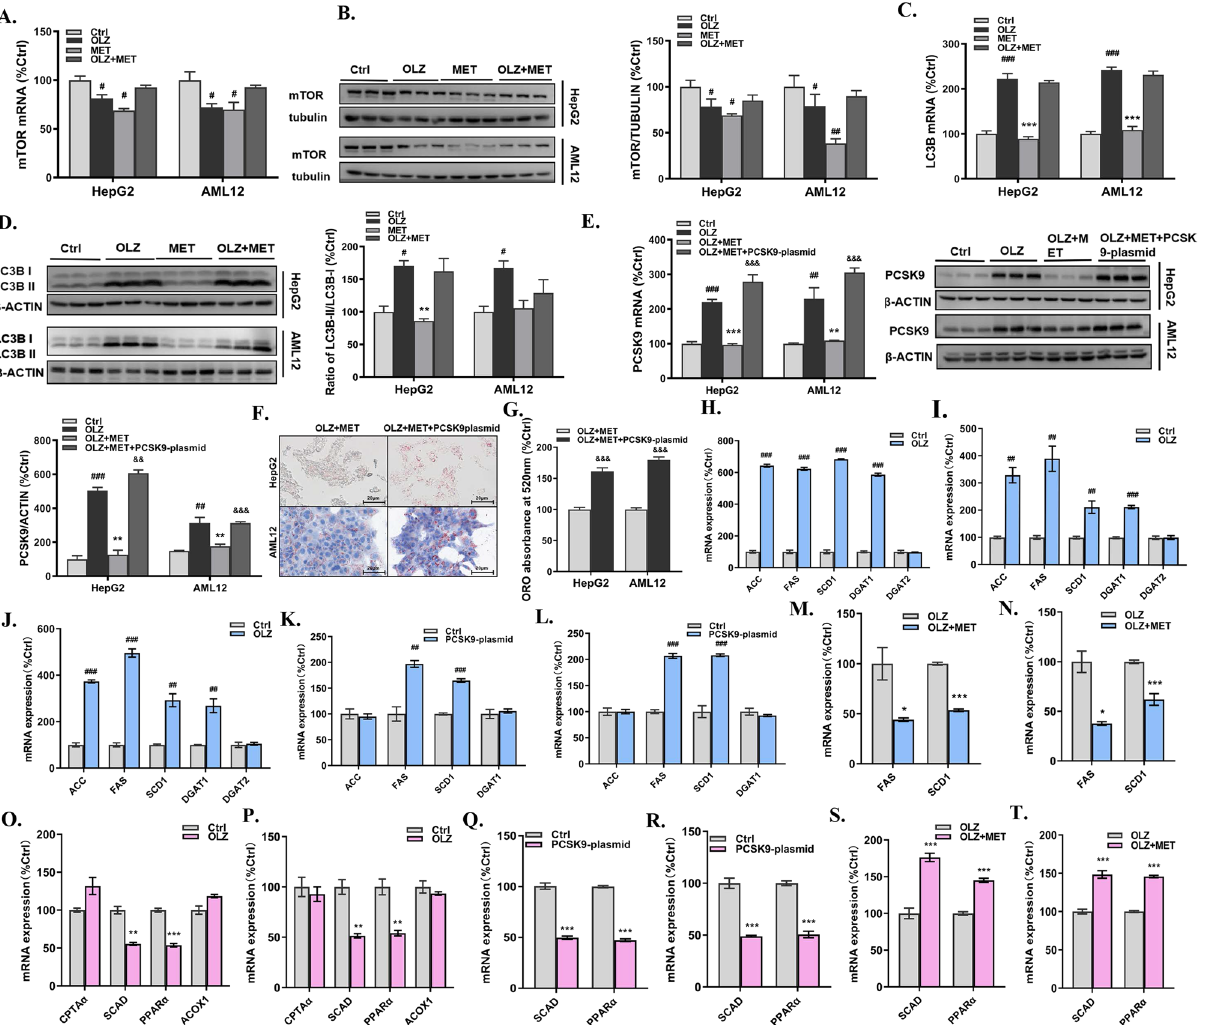
Figure 3. Metformin alleviates olanzapine-induced hepatic lipid accumulation by inhibiting PCSK9 and lipid synthesis-related gene expression in vivo and in vitro. mTOR ( A ) mRNA and ( B ) protein levels in HepG2 cells and AML12 cells. ( C ) LC3B mRNA levels in HepG2 cells and AML12 cells. ( D ) Ratio of LC3B II/LC3B I in HepG2 cells and AML12 cells. ( E ) PCSK9 mRNA and protein levels in HepG2 cells and AML12 cells treated with the PCSK9 plasmid. ( F, G ) ORO staining of HepG2 cells and AML12 cells treated with the PCSK9 plasmid. ACC, FAS, SCD1, DGAT1, and DGAT2 mRNA levels in ( H ) mouse liver tissues, ( I ) HepG2 cells and ( J ) AML12 cells. ACC, FAS, SCD1and DGAT1 mRNA levels in ( K ) HepG2 cells and ( L ) AML12 cells treated with the PCSK9 plasmid. FAS and SCD1mRNA levels in ( M ) HepG2 cells and ( N ) AML12 cells treated with the olanzapine and metformin. CPT1α, SCAD, PPARα, ACOX1 mRNA levels in (O) HepG2 cells and ( P ) AML12 cells treated with olanzapine; SCAD and PPARα mRNA levels in (Q) HepG2 cells and (R) AML12 cells treated with PCSK9 plasmid; SCAD and PPARα mRNA levels in ( S ) HepG2 cells and ( T ) AML12 cells treated with olanzapine and metformin. OLZ, olanzapine; MET, metformin. Data represent the mean ± SEM. ## p < 0.01, ### p < 0.001 vs. control; ** p < 0.01, *** p < 0.001 vs. olanzapine; one-way ANOVA plus Tukey’s post-hoc